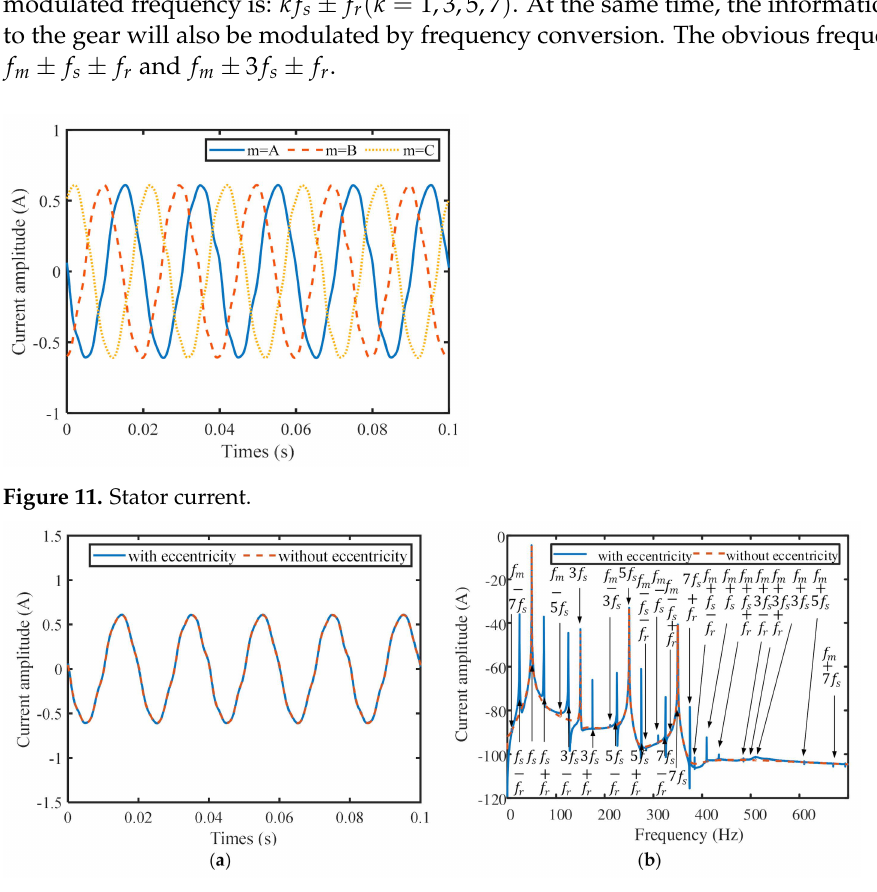
Figure 12. A phase stator current with or without eccentricity. ( a ) Time domain and ( b ) frequency